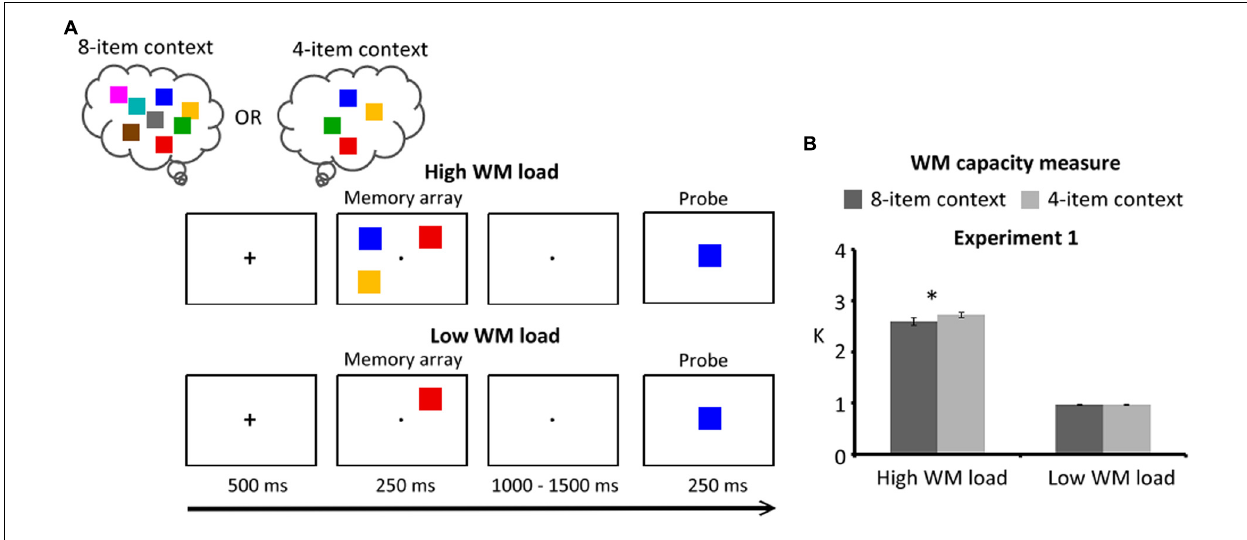
FIGURE 1 | (A) Schematic illustration of the delayed response task of Experiment 1. Participants viewed a memory array consisting of three colors (high WM load) or one color (low WM load) at the beginning of the trial (250 ms duration). Following a randomized retention interval (1000–1500 ms duration), a probe item was centrally presented for 250 ms. Participants were instructed to indicate whether the remembered item was present (50%) or absent (50%). Selection history was defined as the number of items that have been activated in the task context (e.g., 4-item and 8-item). These two task contexts were presented in a block